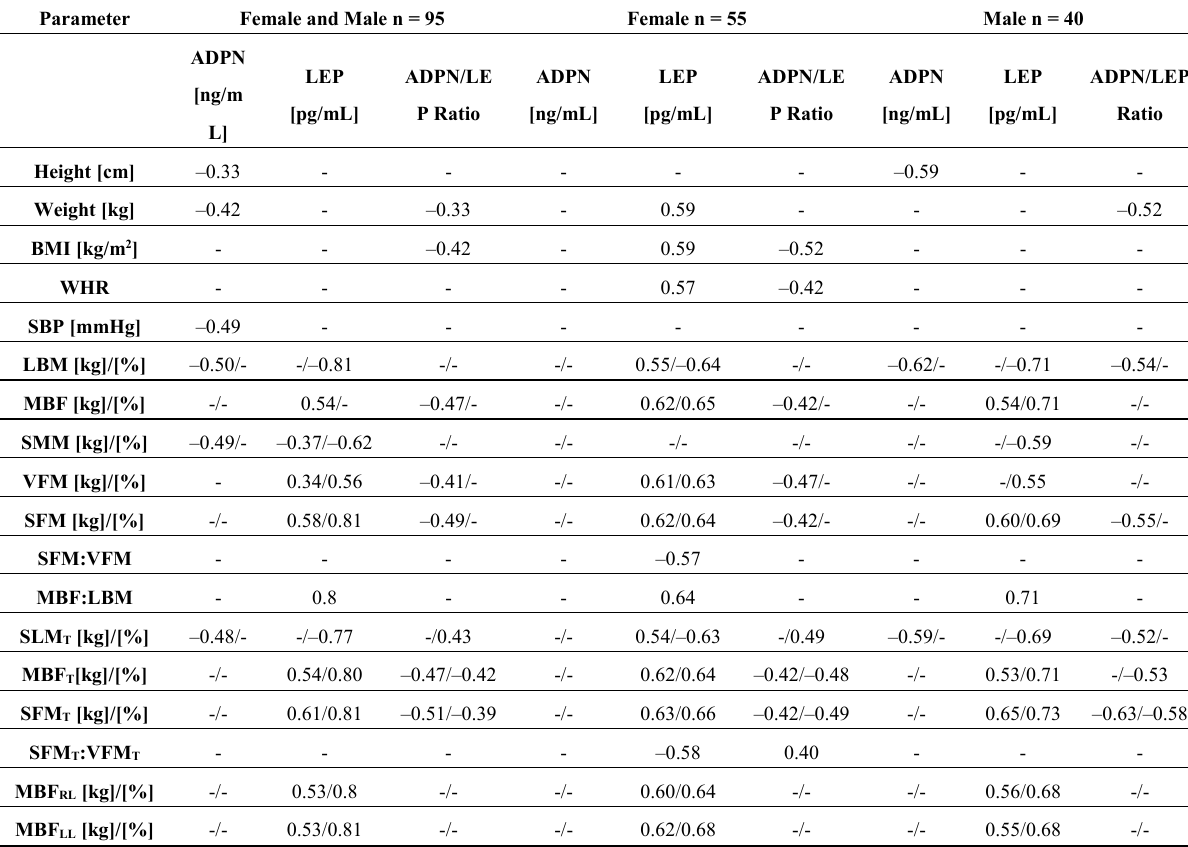
Table 3. Significant correlations ( p < 0.05) between serum adiponectin (ADPN) and leptin (LEP) and selected parts of the body, including division into sex